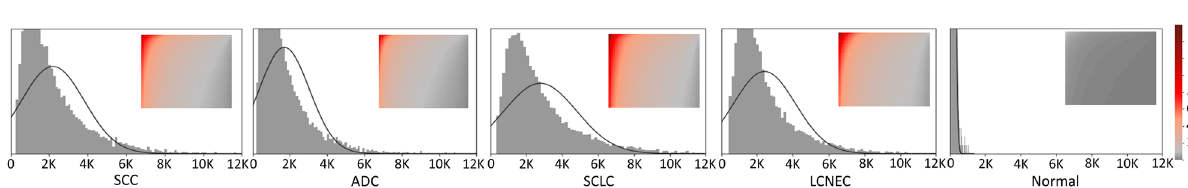
Figure 7. The original WSIs (left), patch-wise probability maps (middle), and HipoMaps (right) of the three samples, N-237-3069, N-681-1513, and ADC-951-8686.